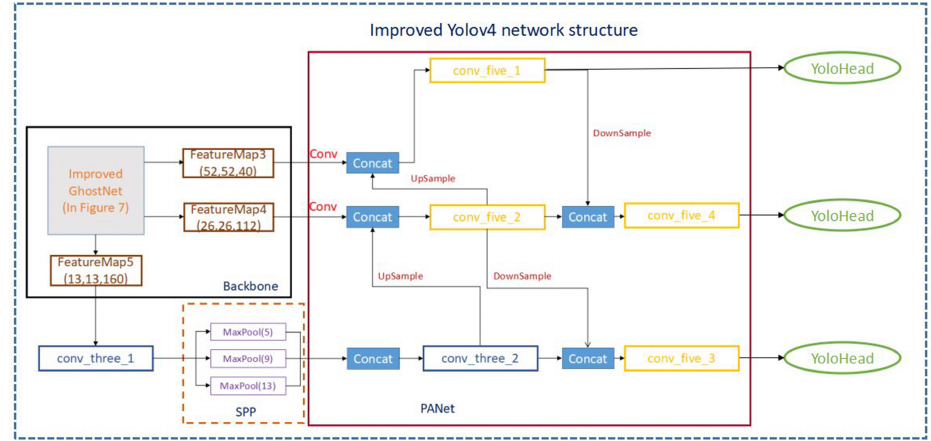
Figure 8. Improved YOLOv4 network structure. The detailed parameters of the improved convolution